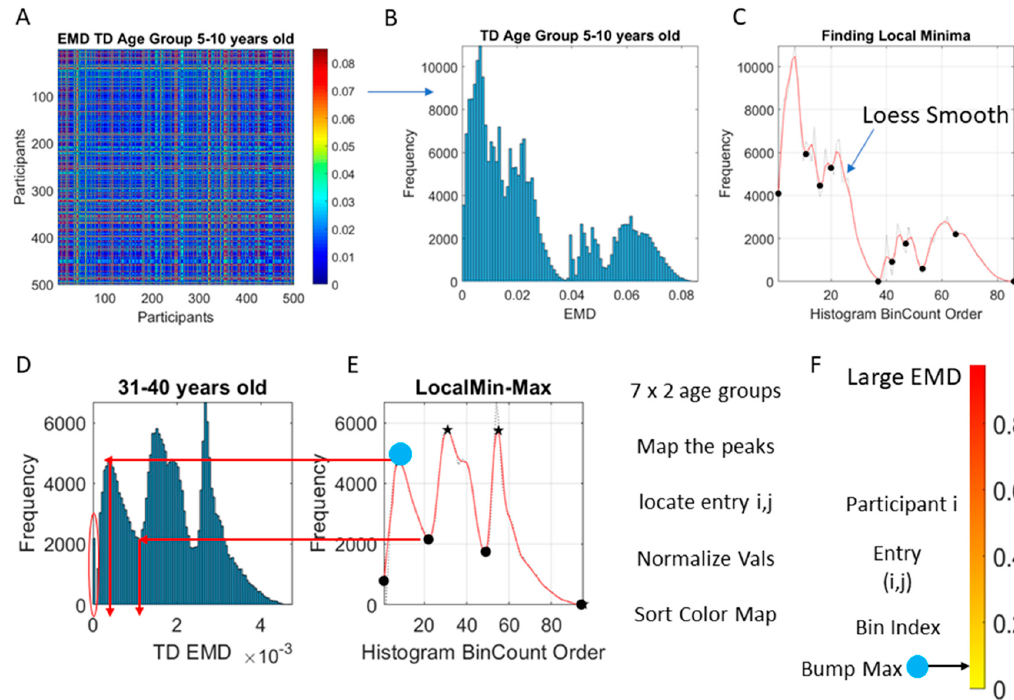
Figure 3. Methods: ( A ) Sample adjacency matrix built using the pairwise EMD across all 500 participants of the 5–10-year-old group. ( B ) Multi-modal frequency histogram of EMD values across the matrix entries. ( C ) Curve of the bin count order represented in the jagged dashed curve smoothed using loess method to localize the local minima and maxima. ( D ) Another sample multi-modal histogram and multi-peaked curve derived from it to explain the process of clustering. Each local minima and maxima are automatically detected along the histogram bin count order spanning the red curve and mapped back to the original histogram of EMD values. As such, given a participant i vs. all other participants, we can localize its maximal distance across the entire age group as the blue circle in ( E ). ( F ) These values are then mapped to a normalized scale and used to color the individual points in the scatter according to their values. For example, here the blue dot representing the local maxima from the first bump is localized along the color bar representing the full range spanned by all age groups in the TD and ASD